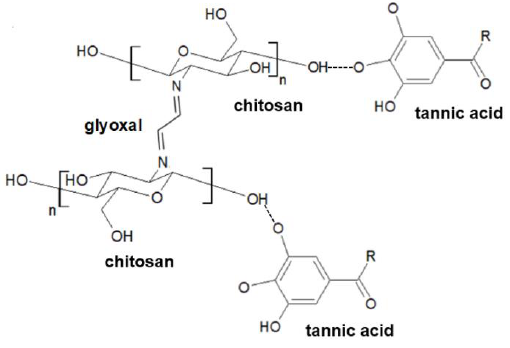
Figure 11. The schematic cross-linking mechanism of chitosan by